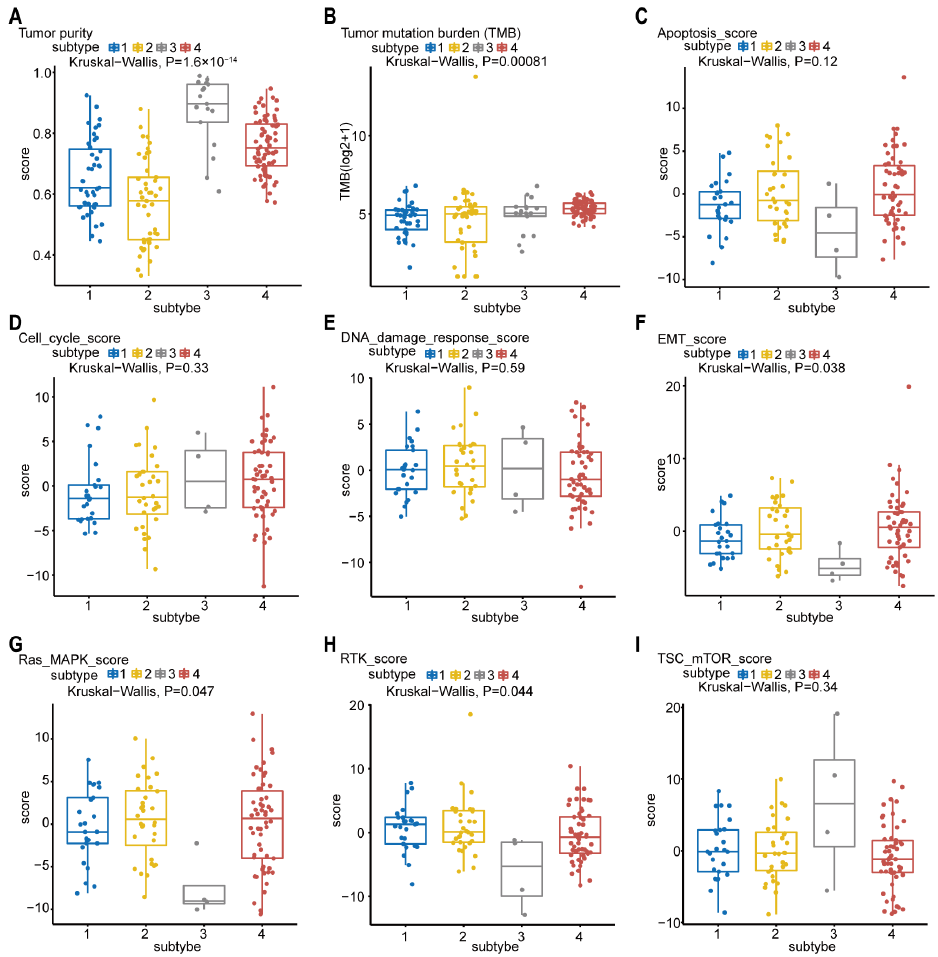
Figure 5. Phenotype heterogeneity among the network-based subtypes. Boxplots show differences in ( A ) tumor purity, ( B ) tumor mutation burden, ( C ) apoptosis, ( D ) cell cycle, ( E ) DNA damage response, ( F ) EMT, ( G ) Ras/MAPK, ( H ) RTK, and ( I ) TSC-mTOR scores from TCGA among network-based subtypes. The data from A were derived from ABSOLUTE. The data from B were obtained using